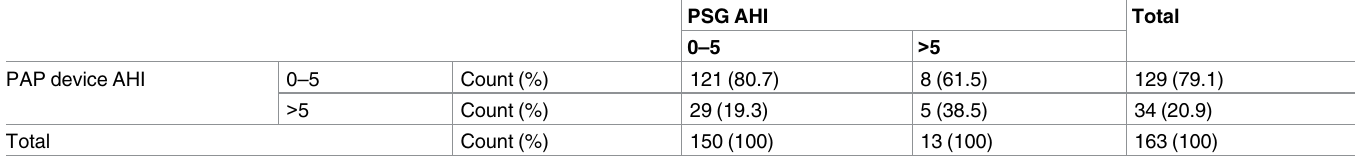
Table 3. 2 × 2 table for PSG and PAP device